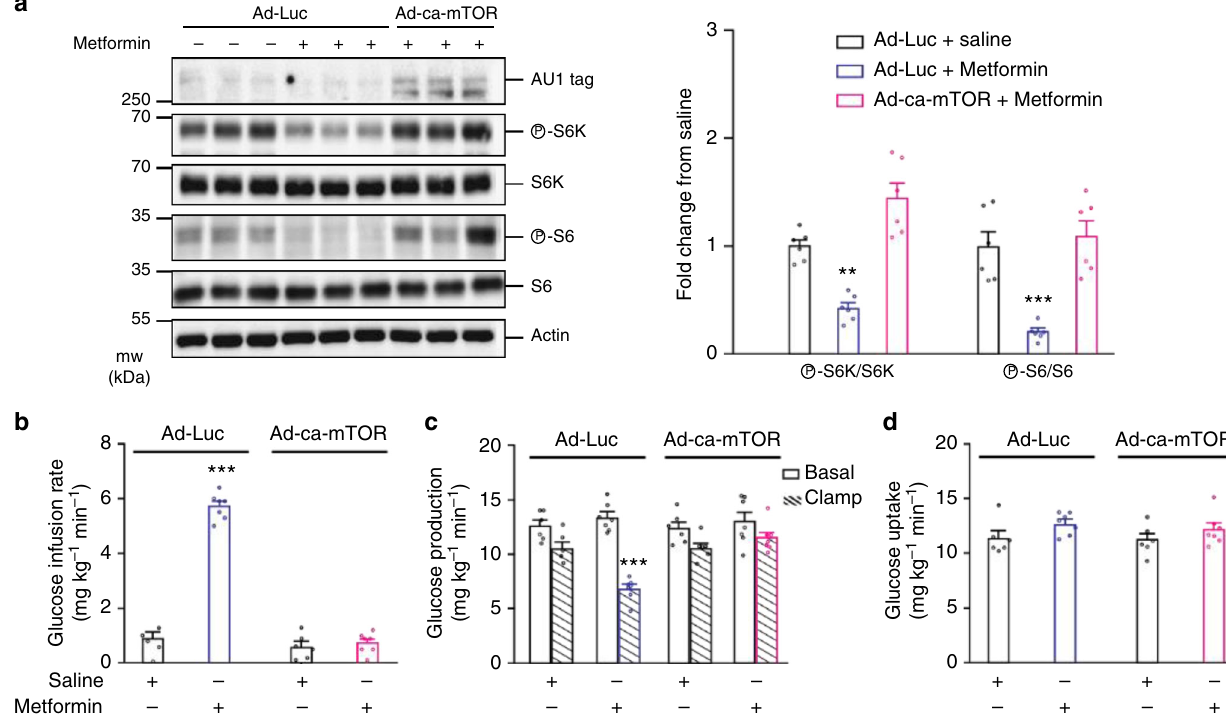
Fig. 3 Upper small intestinal mTOR inhibition is necessary for metformin action. a Representative western blot (left) and quantitative analysis (right) of phosphorylated S6K, and S6 protein expression normalized to their respective total protein expression in HEK293 cells infected with either Ad-Luc or Ad- ca-mTOR and then treated with saline or metformin for 12 – 16 h. AU1, tag protein for mTOR construct; Actin, loading control. ** p < 0.01 or *** p < 0.001 vs. all other groups as determined by ANOVA with Tukey ’ s post hoc test ( n = 6 for each group). b – d Glucose infusion rate ( b ), glucose production ( c ), and glucose uptake ( d ) during the clamp in HFD-fed rats infected with either upper small intestinal Ad-Luc or Ad-ca-mTOR and infused with upper intestinal saline ( n = 6 for each group) or metformin ( n = 7 for each group). *** p < 0.001 vs. all other groups as determined by ANOVA with Tukey ’ s post hoc test. Values are shown as mean ±